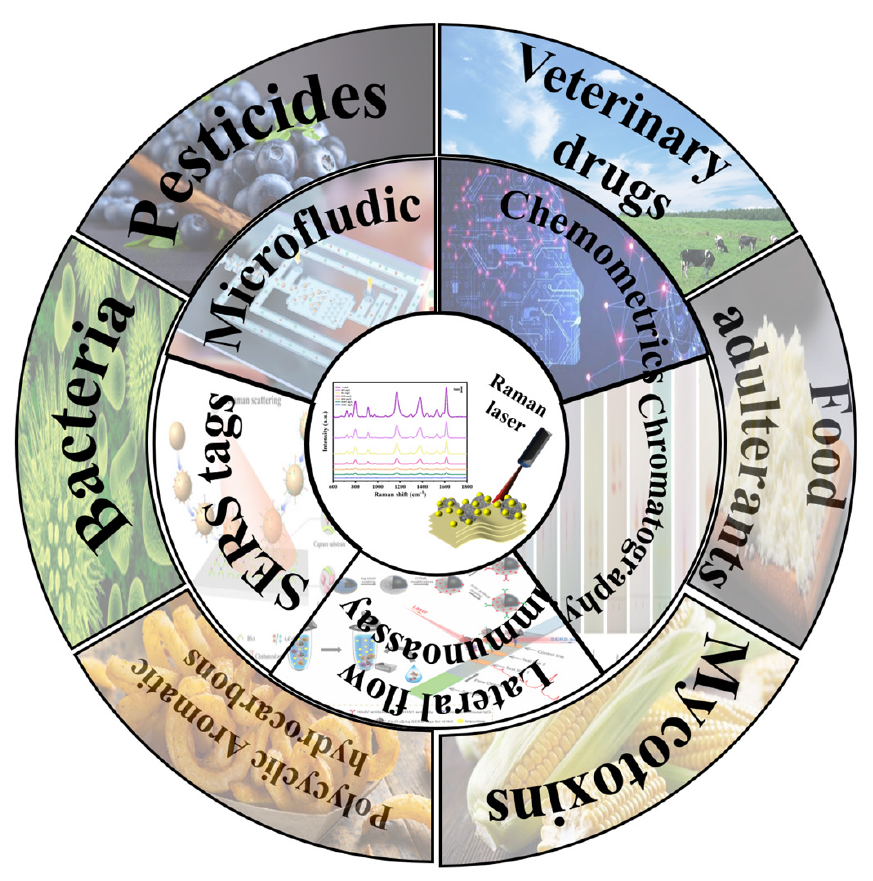
Figure 1. Illustration of SERS − based multicomponent detection in the food industry.